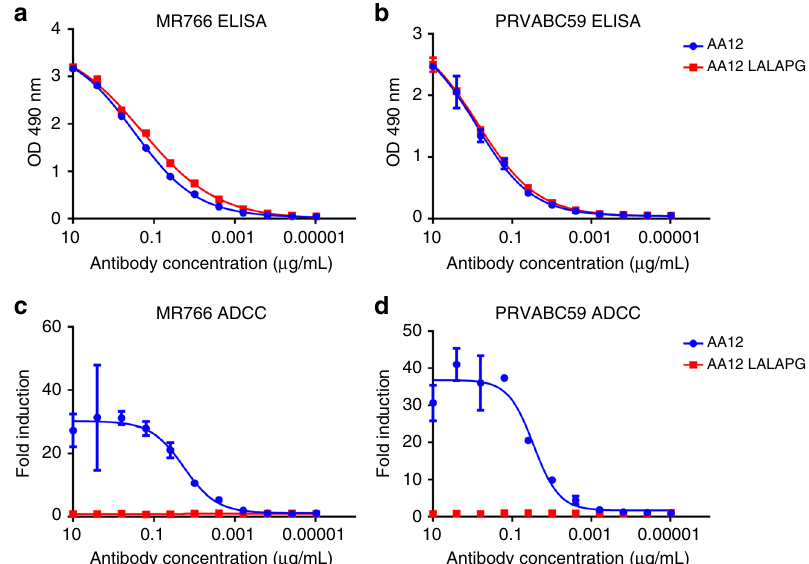
Fig. 5 LALAPG mutation ablates Fc-FcR mediated effector functions without affecting af fi nity. The variable region of AA12 was cloned into human IgG1 or human IgG1 with L234A, L235A, and P329G mutations (LALAPG) in the backbone. a , b ELISA assays were performed using recombinant NS1 from either MR766 and PRVABC59 viruses to assess the binding activities of mAbs AA12 and AA12 LALAPG. c , d Fc-FcR mediated effector functions were tested on Vero cells infected with MR766 and PRVABC59 Zika viruses. AA12 was able to elicit Fc-FcR mediated effector functions while AA12 LALAPG was not. Assays were performed twice as technical duplicates and one of two replicates is shown. A non-linear regression best- fi t curve was generated for each dataset using GraphPad Prism 5. Error bars represent